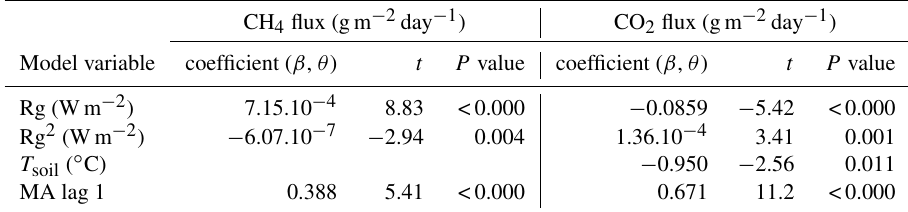
Figure 4. Diurnal cycles of CH 4 (above) and CO 2 (below) from March to November 2013. Each point represents the flux averaged over a specific hour of the day averaged over 1 month. Error bars denote standard deviations. Table 1. Model parameters and statistics of the CO 2 and CH 4 ARIMA (0, 1, 1)